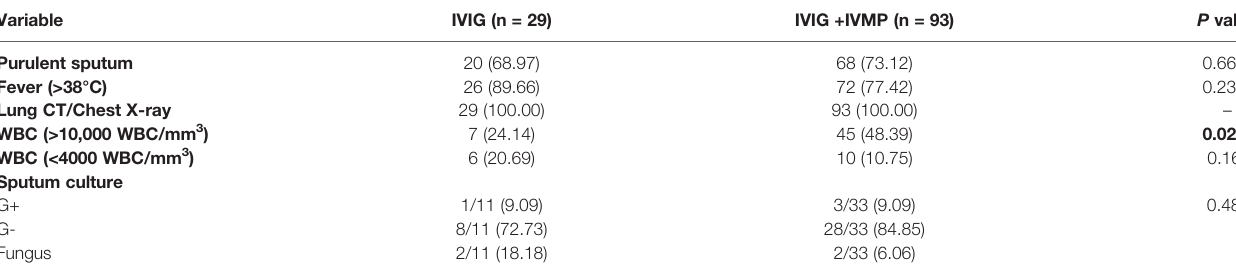
TABLE 4 | Symptoms/radiologic/laboratory data for patients with pneumonia in both groups.